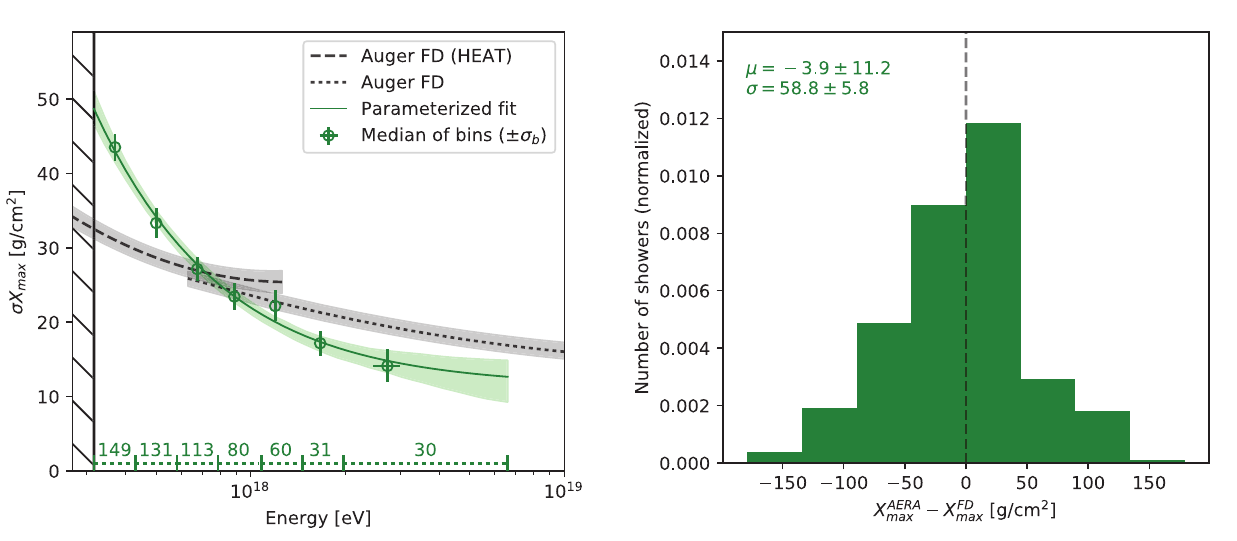
Figure 2. Distribution of di ff erences between AERA and FD reconstructed X max values for the set of hybrid showers. Inset at the top are the mean and width of the di ff erences as determined with bootstrap